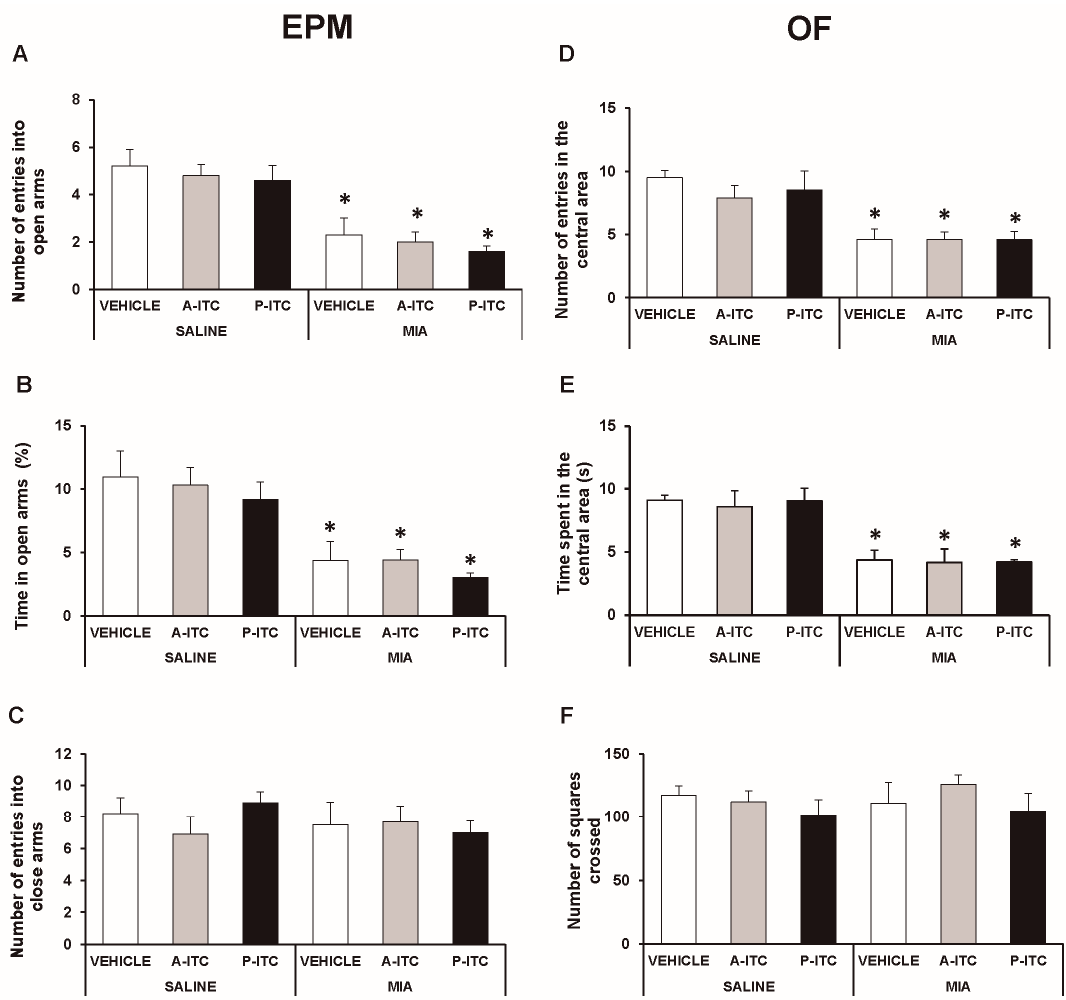
Figure 3. Treatment with A-ITC or P-ITC does not alter the anxiety-like behaviors associated with chronic osteoarthritis pain. The anxiety-like behaviors were evaluated on day 29 after MIA or SS injection and at 4 or 10 days of treatment with A-ITC or P-ITC in the elevated plus maze (EPM) and open field (OF) tests. In the EPM, ( A ) the number of entries into the open arms, ( B ) percentage of time spent in the open arms, and ( C ) the number of entries into the closed arms are shown. For OF, ( D ) the number of entries into the central area, ( E ) time spent in the central area (s), and ( F ) the number of squares crossed are shown. For each test evaluated, * denotes significant differences vs. their respective SS-injected mice ( p < 0.05; one-way ANOVA followed by the Student-Newman-Keuls test). The results are presented as the mean ± SEM; n = 10 animals per experimental group.